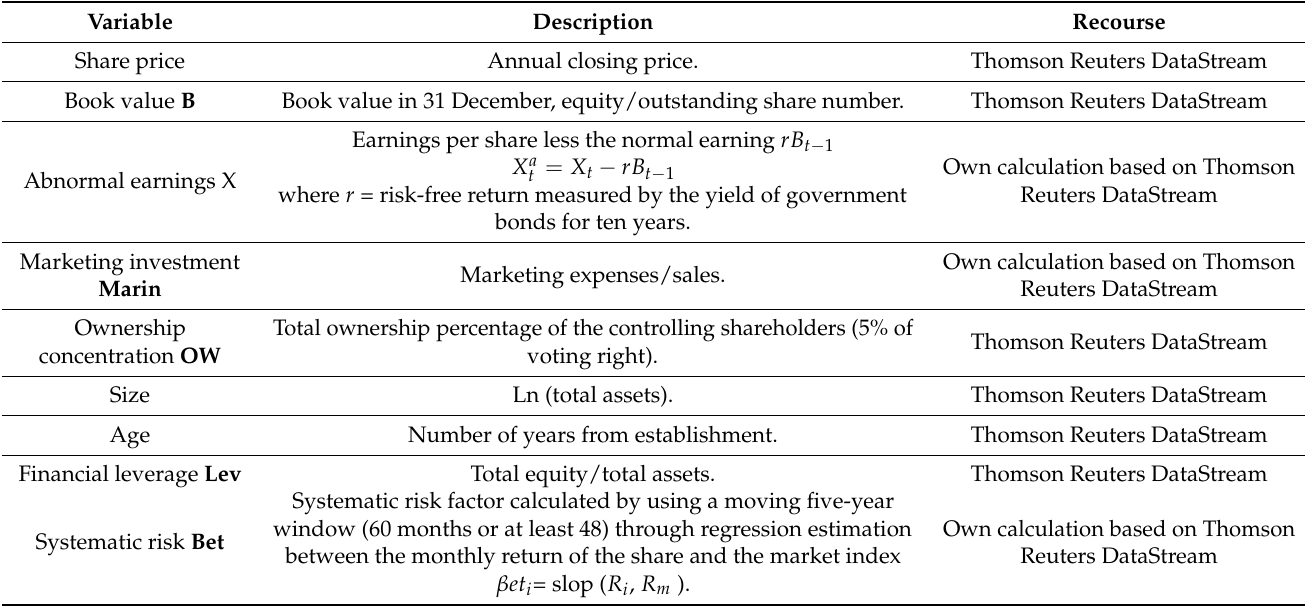
Table 2. Definition of research